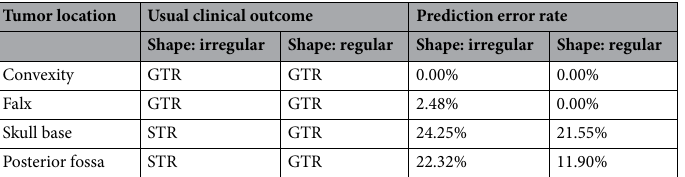
Table 4. Usual clinical outcomes and prediction error rates (using the test samples) for the stepwise logistic regression model with three features.